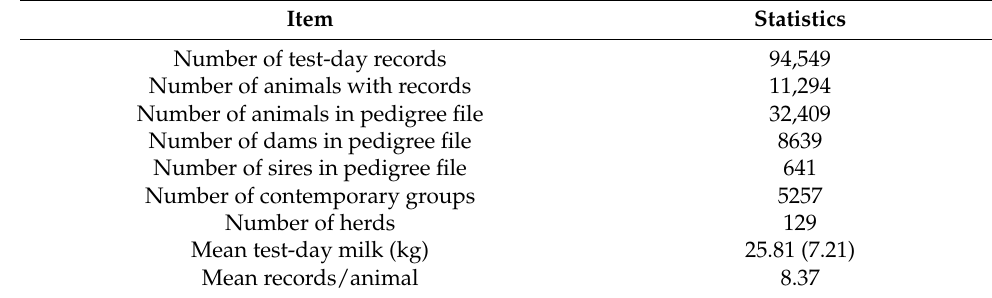
Table 1. Overall traits of first-parity Brazilian Holstein cattle (SD in